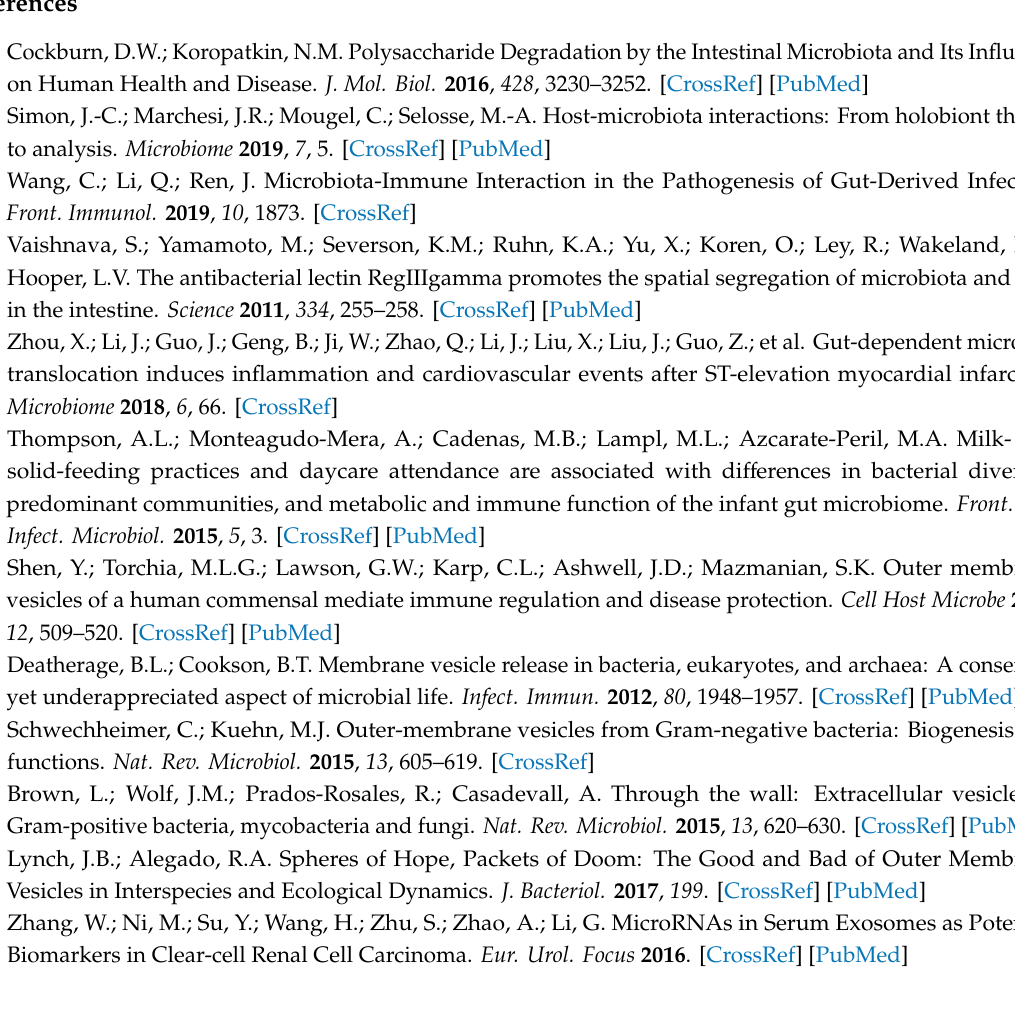
Figure S1 : Scanning electron microscopy (SEM) of pig fecal culture grown on basal medium with no carbon source ( A ) or supplemented with 2% mannan ( B ). SEM were observed with magnification of 10000 × , Figure S2 : MALDI-TOF MS analysis of degradation products obtained from oligosaccharides as a result of action of EVs and supernatant (Sup) from 2% mannan and 0% mannan (control) on Man5 ( A ), KGM ( B ), CGM ( C ) and AcGGM ( D ). A green box indicates activity, the orange box indicates low activity, while the red box indicates the absence of detectable products. All masses represent sodium adducts. Numbers in green denote mannooligosaccharides. Unlabeled peaks represent background signal. Numbers in purple show persistent contaminants. The data shown are representative of three independent replicates. ( E ) Summary of the activity of the supernatant (Sup) and EVs from control and 2% mannan treatment on di ff erent glycans under standard assay conditions, Table